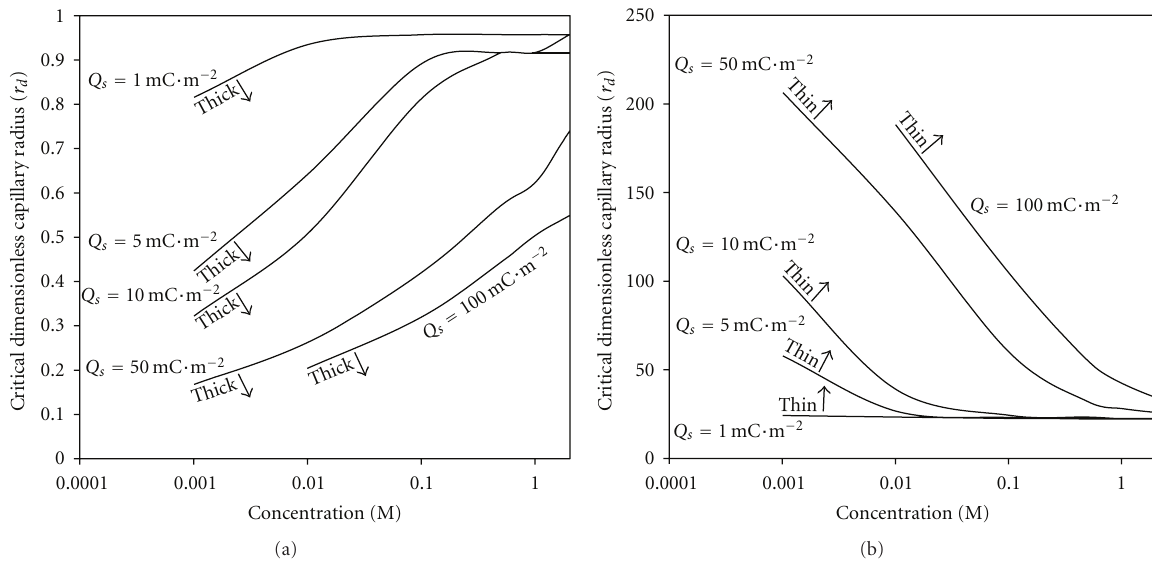
Figure 6: Critical dimensionless capillary radius (determined from Figure 3) (a) below which the thick double-layer assumption is valid and (b) above which the thin double layer assumption is valid, as a function of electrolyte concentration. Curves correspond to surface charge values of 1, 5, 10, 50, and 100 mC · m − 2 . The thick double-layer assumption is taken to be valid when the dimensionless streaming current I d deviates from 0 by less than 1%; the thin double-layer assumption is taken to be valid when I d deviates from 1 by less than 1%.